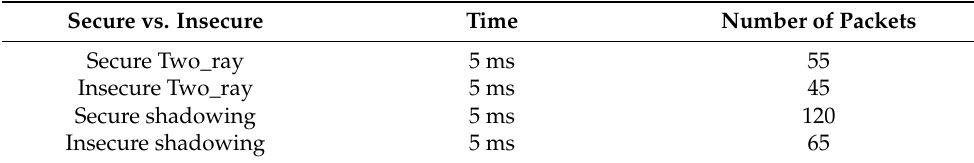
Table 6. The number of packets versus time in throughput parameter.